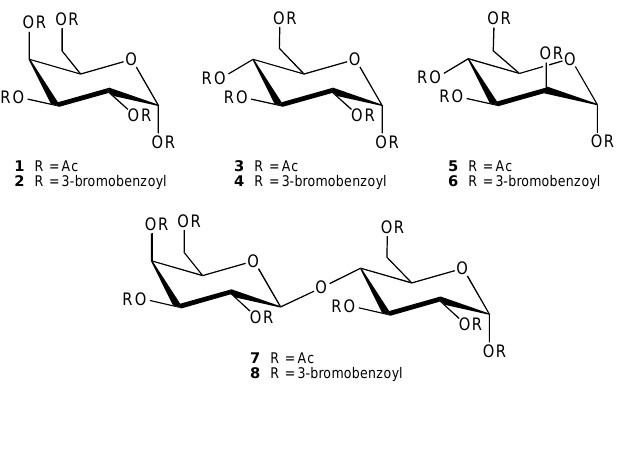
Figure 1. The structure of fully acetylated and 3-bromobenzoylated sugars.